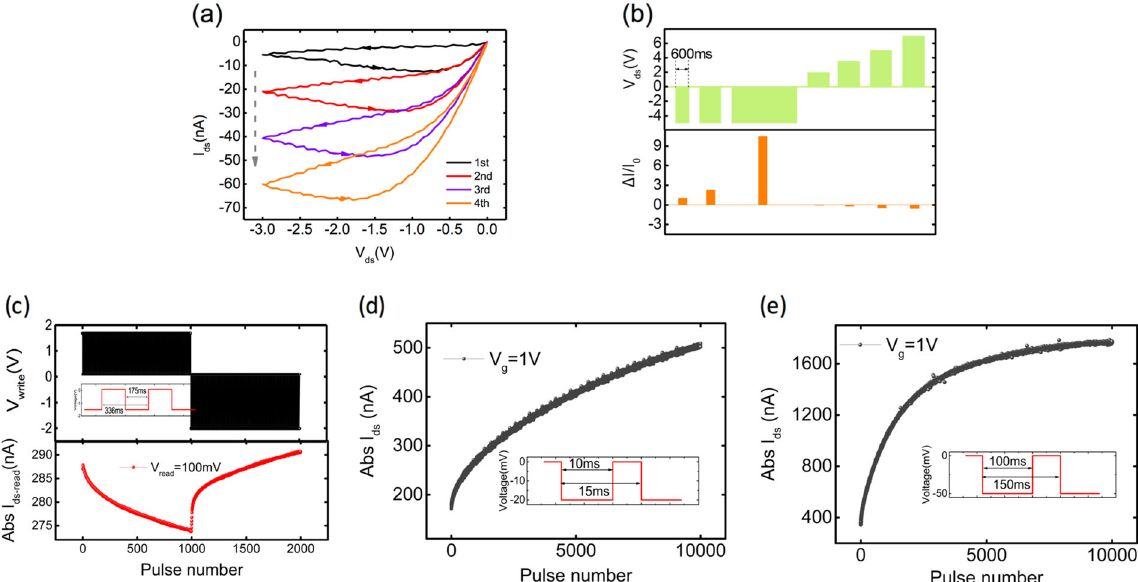
Fig. 2 Memristive features of the FMT. a Consecutive I – V scanning at a negative V ds . b Responses to pulses with different intensities and durations. c Read current for 1000 identical positive pulses ( V d = 1.7 V, 175 ms pulse width, 336 ms period) followed by 1000 identical negative pulses ( V d = − 2 V, 175 ms) with V g = 0 V. After each pulse, the read current was measured at V d = 0.1 V (small enough at V g = 0 V to eliminate the effect of the reading process) to show the current change induced by the previous pulse. The interval between two writing pulses was 161 ms. d Response to 10,000 pulses ( − 20 mV, 10 ms pulse width, 15 ms period) at V g = 1 V. e Response to 10,000 pulses ( − 20 mV, 100 ms pulse width, 150 ms period) at V g = 1 V. a, b were tested on a device with L = 20 µm and W = 50 µm, ( c ) was tested on a device with L = 80 µm and W = 100 µm, ( d, e ) were tested on a device with L = 30 µm and W = 200